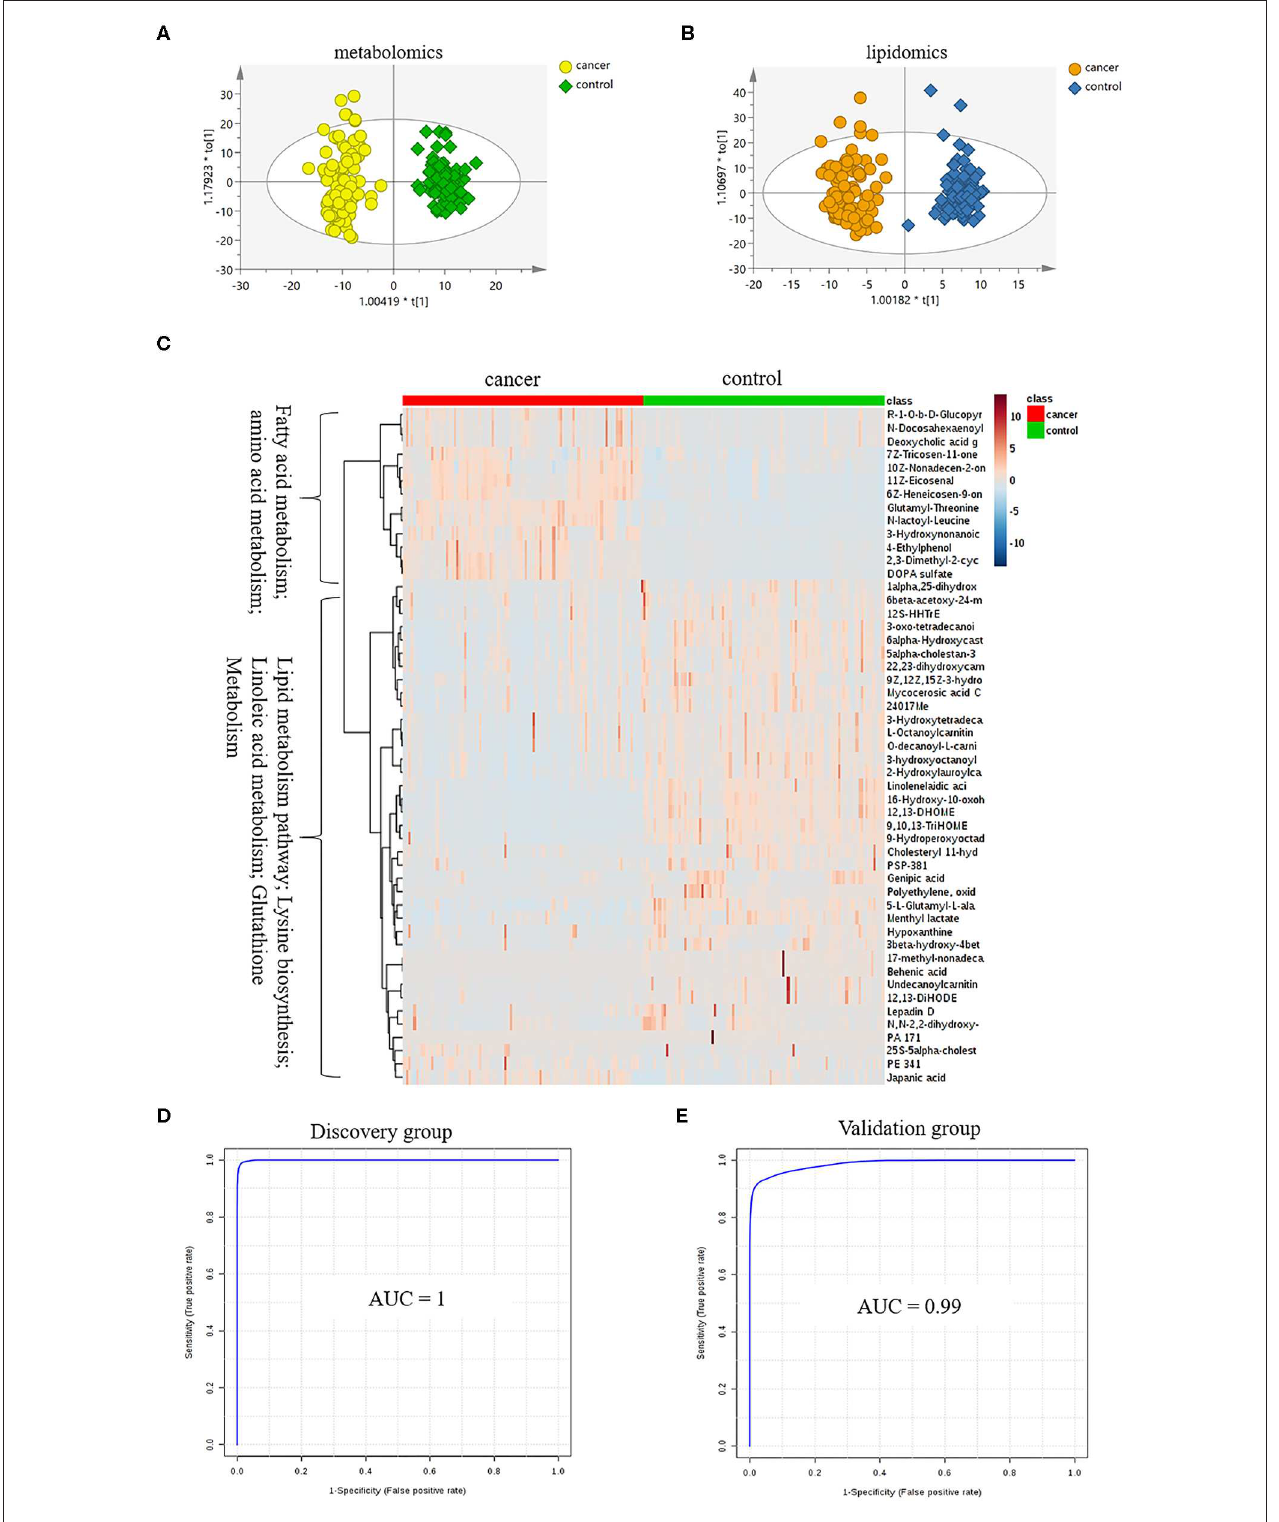
FIGURE 2 | Analysis of plasma metabolomics and lipidomics of 95 cancer samples (42 BC and 53 RCC) and 95 healthy control samples. (A) Score plot of OPLS-DA based on plasma metabolic profiling of cancer and control. (B) Score plot of OPLS-DA based on plasma lipidomic profiling of cancer and control.